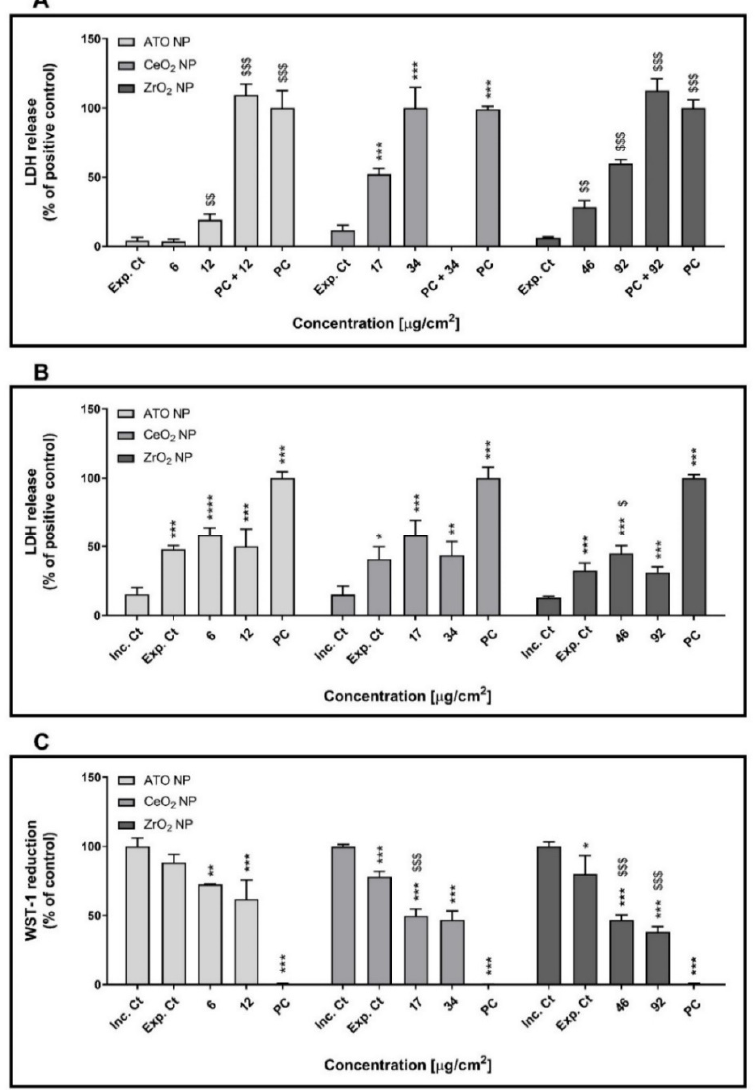
Figure 5. Cytotoxicity of the aerosolised engineered nanoparticles (ENP) (ATO, CeO 2 and ZrO 2 ) in polarised cultures of human alveolar epithelial cells at air-liquid interface (ALI) conditions. Lactate dehydrogenase release (LDH) was assessed immediately after (0 h) ( A ) and at 24 h ( B ) after exposure. ( C ) WST-1 reduction assay was carried out only in the recovery period (24 h after exposure).